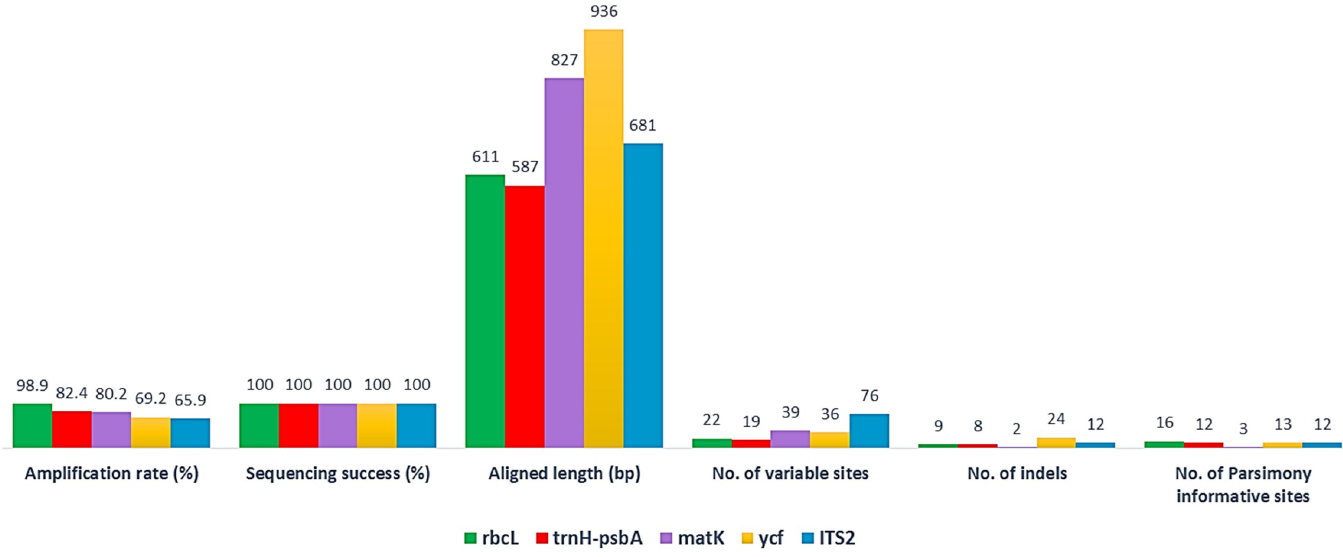
Fig 2. The success rates of PCR amplification and sequencing of the five-barcode fragment and 26 different geographical locations.